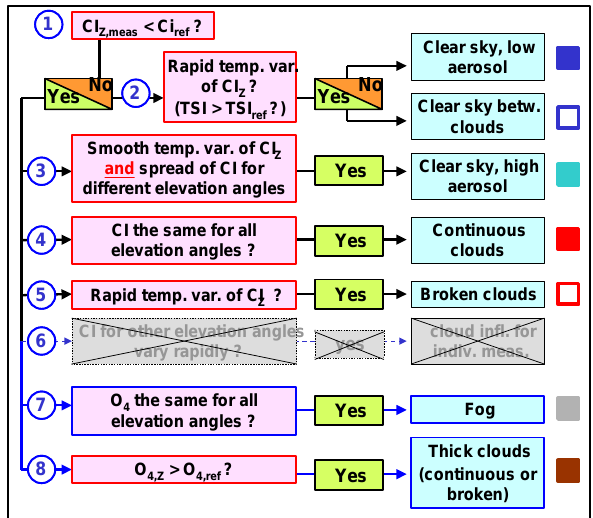
Figure 9. Flow chart of the updated cloud classification scheme. The basic structure is the same as in the original scheme (Fig. 14 in Wagner et al., 2014). However, except for the decision criterium for fog (decision no. 7), all other criteria were changed compared to the original scheme. The individual changes are summarised in Table 1. For decision no. 6, no universal recommendation can be given, be- cause the spread of the non-zenith angles depends in particular on the relative azimuth angle. Thus it is omitted in the updated classi- fication